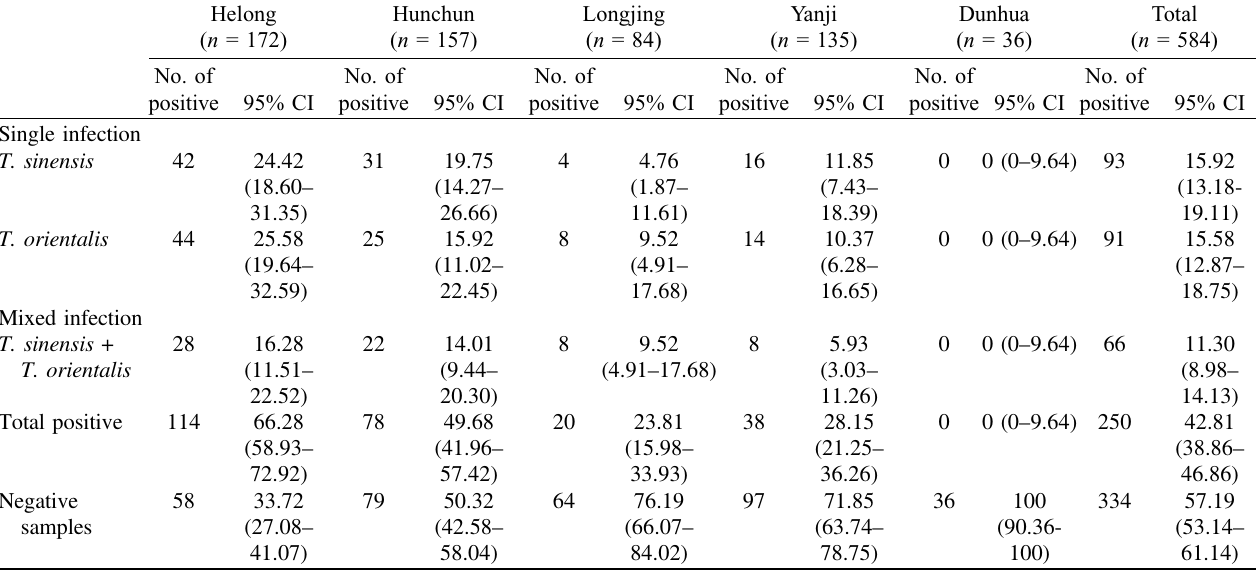
Table 2. The single and mixed infection rates of Theileria spp. in cattle in Jilin,